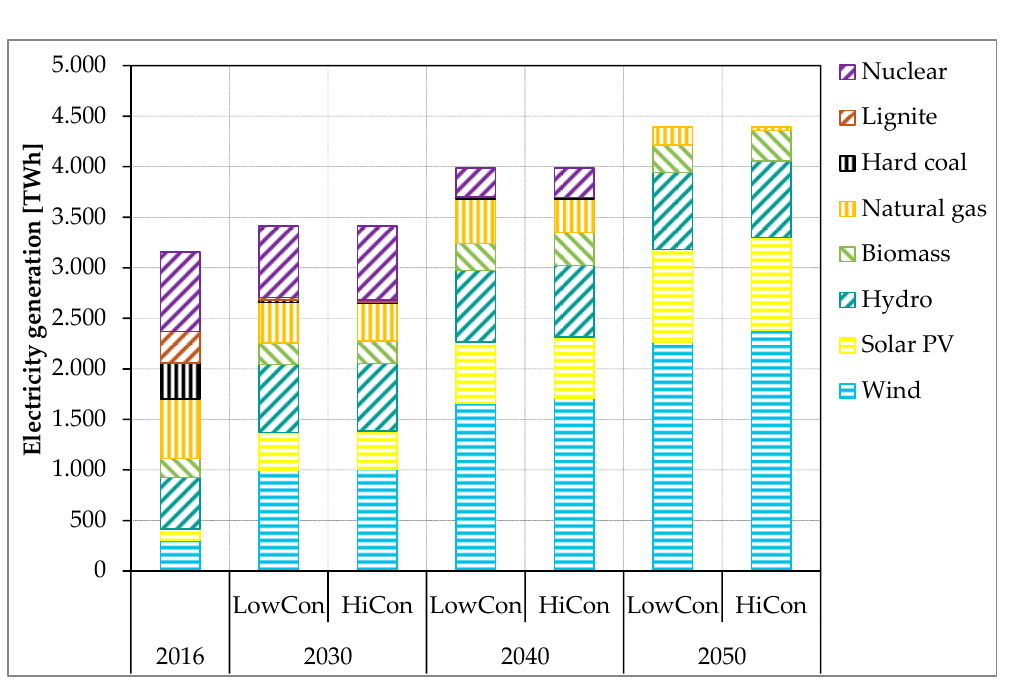
Figure 9. Electricity exchange and transit flows in relation to electricity demand.